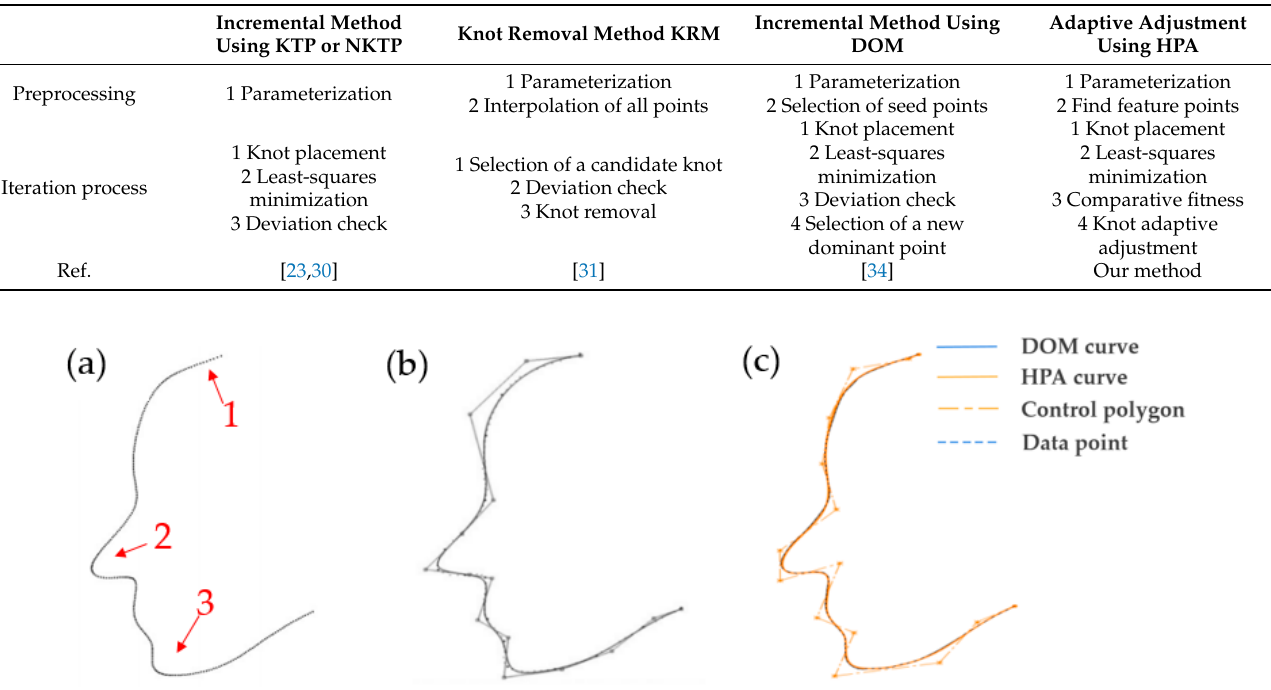
Table 1. Comparison of related fitting methods.